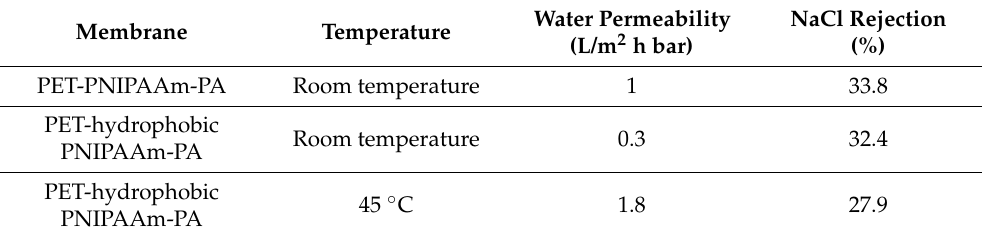
Table 5. The effect of temperature on TFC PA membrane